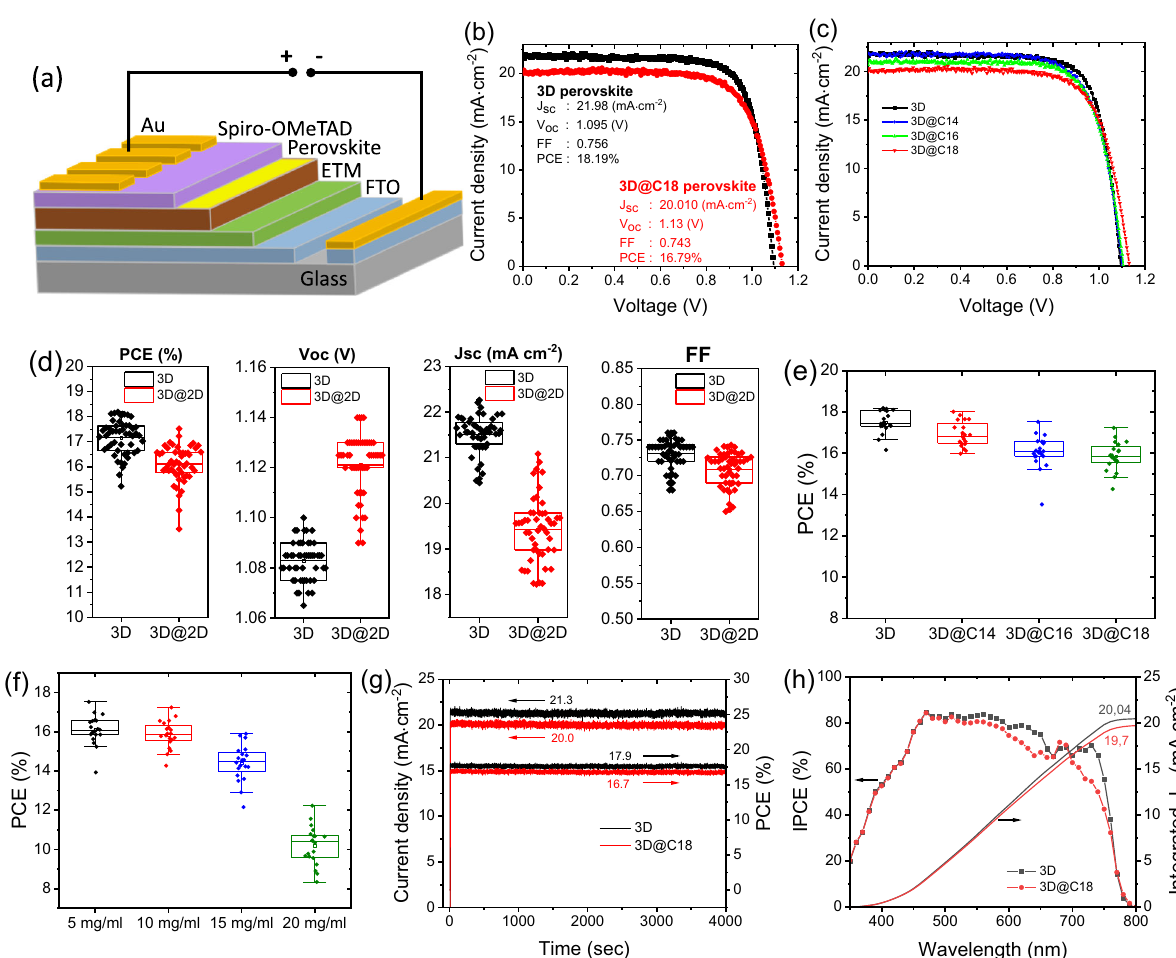
Fig. 2 Comparison of 3D-only and 3D@2D perovskite solar cell performance. a Schematic illustration of 2D-coated perovskite solar cell (PSC) with regular con fi guration, b current-voltage characteristic of 3D-only and C18 perovskite-coated PSCs, c comparison of the current – voltage characteristic of 3D-only and 2D perovskite-coated PSCs. Photovoltaic parameters determined from the J – V characteristic of a relevant number (50 in total) of 3D-only and C18 perovskite-coated PSCs: d PCE, open-circuit voltage ( V oc ), short-circuit current density ( J sc ) and fi ll factor ( FF ). e The statistical distribution of PCE values of 3D-only and C14, C16, and C18 perovskite-coated PSCs. f Effect of variation in concentration of C18 perovskite per ml THF on PCE values of PSCs. g Steady-state photocurrent density and PCE of the 3D-only and C18-coated PSC monitored at a maximum powerpoint under 1-sun AM 1.5-G illumination. h Incident photon-to-electron-conversion ef fi ciency (IPCE) spectra and the corresponding integrated J sc of 3D-only and C18 perovskite-coated